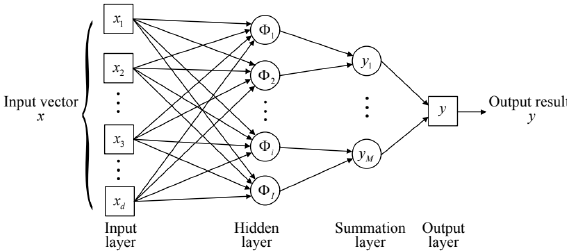
Fig. 7. Structural diagram of probabilistic neural network